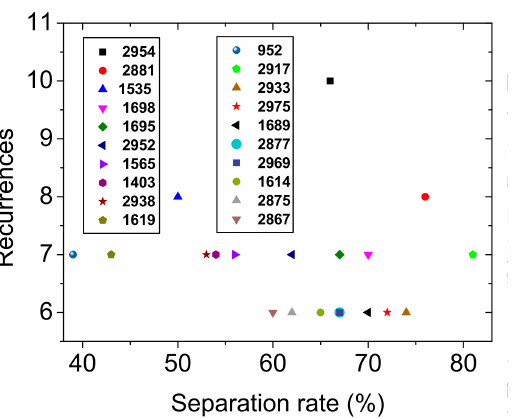
Figure 2. Scatterplot of the top 20 nodes with the highest recurrence in the random forest model of Table 1 and their corresponding percentage of separation